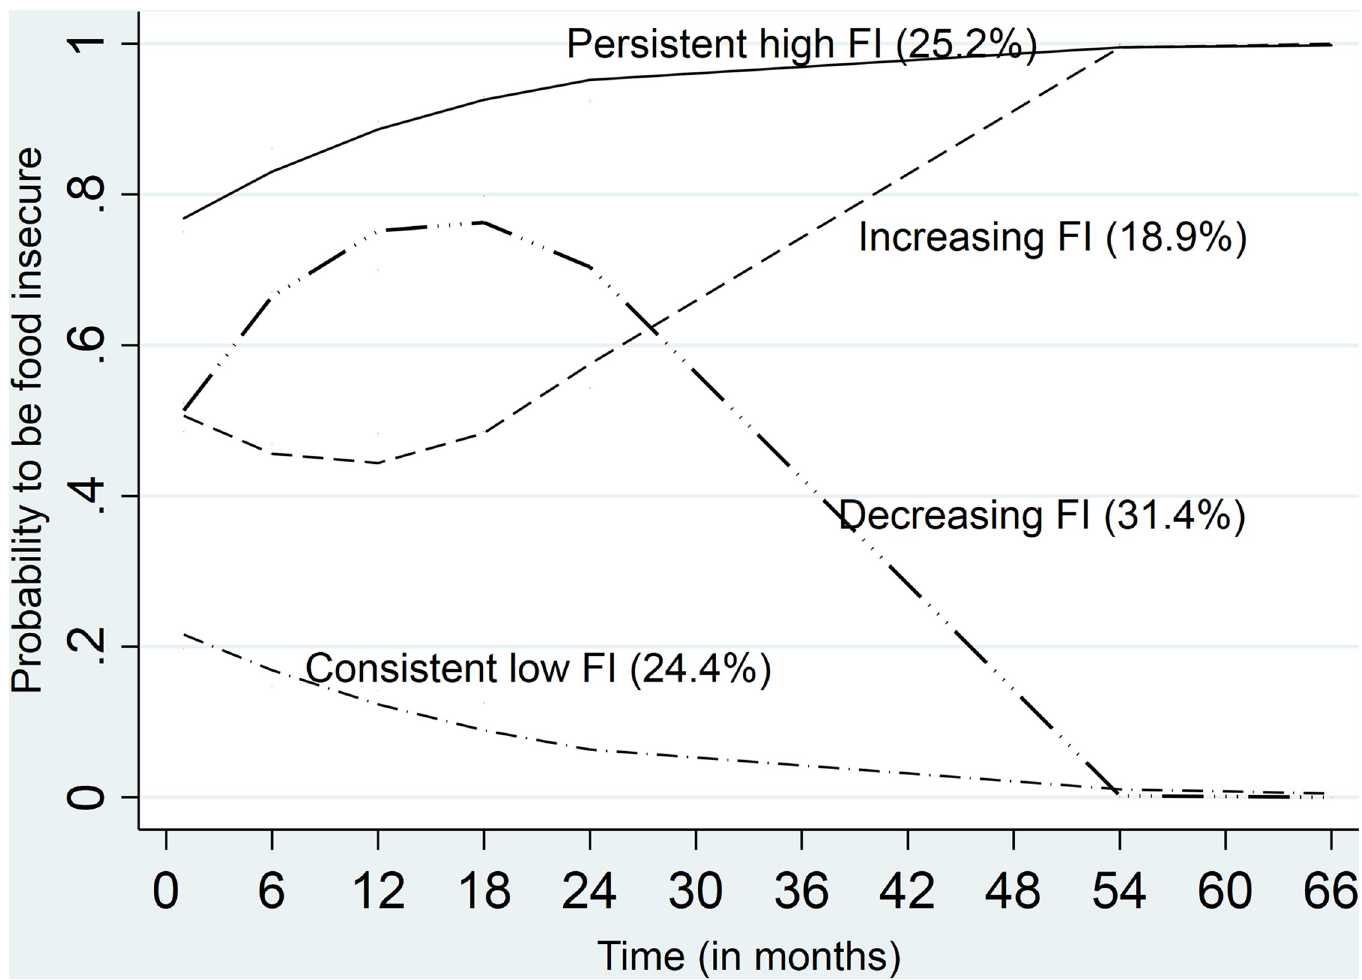
Fig 1. Food Insecurity (FI) trajectories over time points.